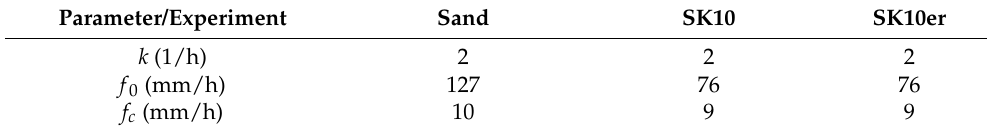
Table 5. Horton infiltration method initial parameters that were used for the rainfall–runoff simulations.